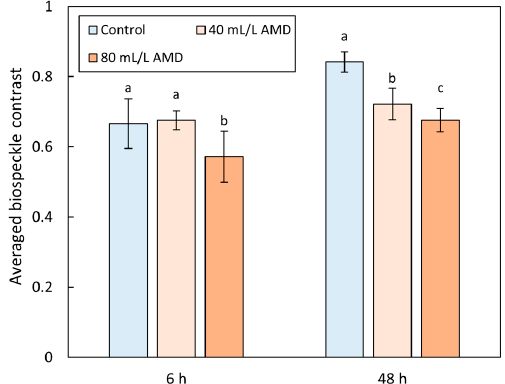
Figure 3. Averaged biospeckle contrast of seeds exposed in AMD for 6 and 48 h. (Different letters, a, b, and c, represent statistical differences between treatments; the error bar represents standard deviation; Fisher LSD multiple comparison; p < 0.05 level; N = 6).